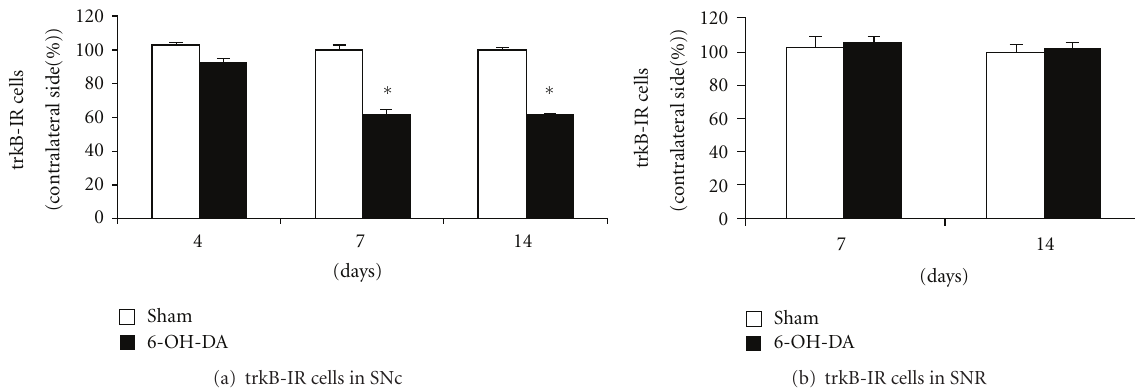
Figure 3: Unilateral 6-OHDA intrastriatal injection results in a significant decrease in the number of trkB-IR cells in ipsilateral SNc at 7 and 14 days after the injection. (a) Percentage of trkB-IR cells in rat ipsilateral SNc compared to the contralateral side after unilateral 6-OHDA (black columns) or ascorbic acid (sham, white columns) intrastriatal injections. Number of cells with trkB-IR signals in contralateral SNc of ascorbate-injected rats per area unit per slice was 507 . 9 ± 7 . 9, 365 . 1 ± 15 . 9, and 412 . 7 ± 10 . 6 cells/mm 2 , at 4, 7, and 14 days after injections, respectively. In the case of 6-OHDA-treated rats, number of cells with trkB-IR signals in contralateral SNc was 484 . 1 ± 15 . 9, 381 . 0 ± 31 . 7 and 404 . 7 ± 15 . 9 cells/mm 2 , at 4, 7, and 14 days after 6-OHDA injections, respectively. (b) Percentage of trkB-IR cells in the ipsilateral SNR compared to the contralateral side, at 7 and 14 days after unilateral intrastriatal injections of 6-OHDA (black columns) or ascorbic acid (sham, white columns). Number of cells with trkB-IR signals in contralateral SNR of ascorbate-treated rats was 117 . 9 ± 5 . 1 and 143 . 6 ± 5 . 1 cells/mm 2 , at 7 and 14 days after injections, respectively. In the case of 6-OHDA-treated rats, the number of cells with trkB-IR signals in contralateral SNR amounted to 117 . 9 ± 5 . 1 and 148 . 7 ± 10 . 3 cells/mm 2 , at 7 and 14 days after toxin injections, respectively. n = 6 rats under each experimental condition. The di ff erent experimental groups were compared by a Kruskal-Wallis nonparametric ANOVA, followed by a U -test. ∗ P < 0 . 05 compared with sham-treated